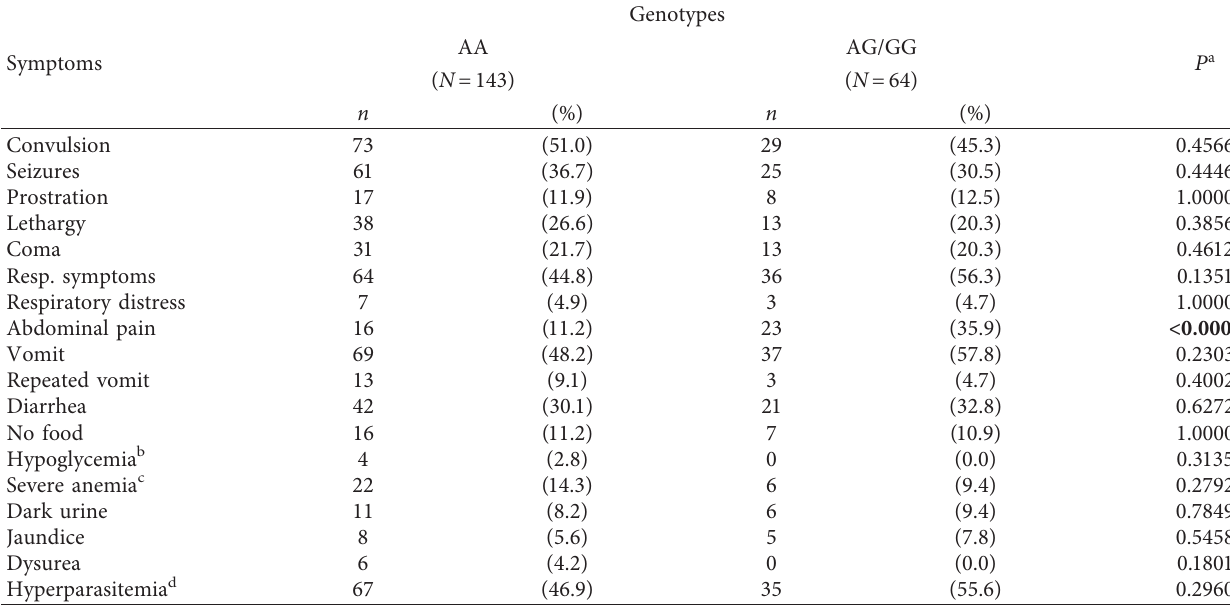
Table 3: Association with symptoms of malaria severity with rs562556